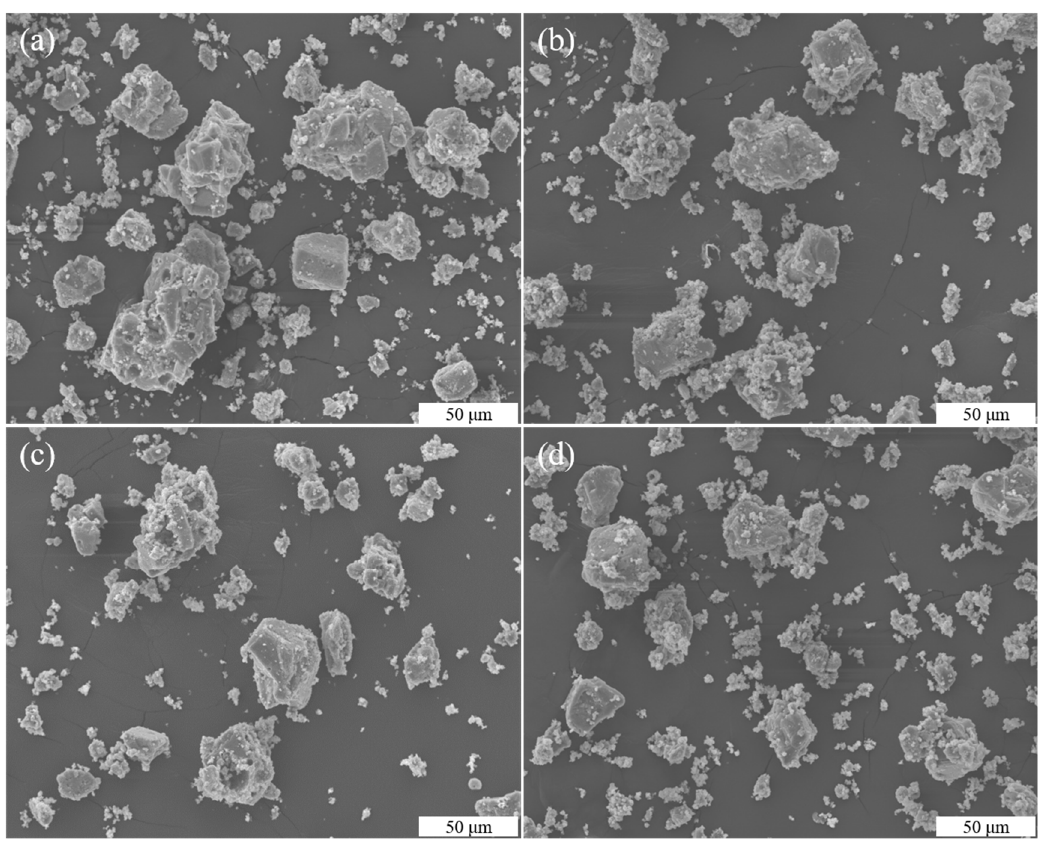
Figure 6. SEM images of CaCO 3 precipitates with different quantities of TCS (TCS = 100 ( a ), 200 ( b ), 300 ( c ), and 400 g ( d )).